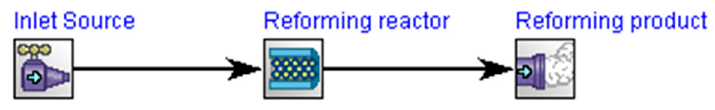
Figure 1. Schematic of n -heptane / toluene reforming in Chemkin